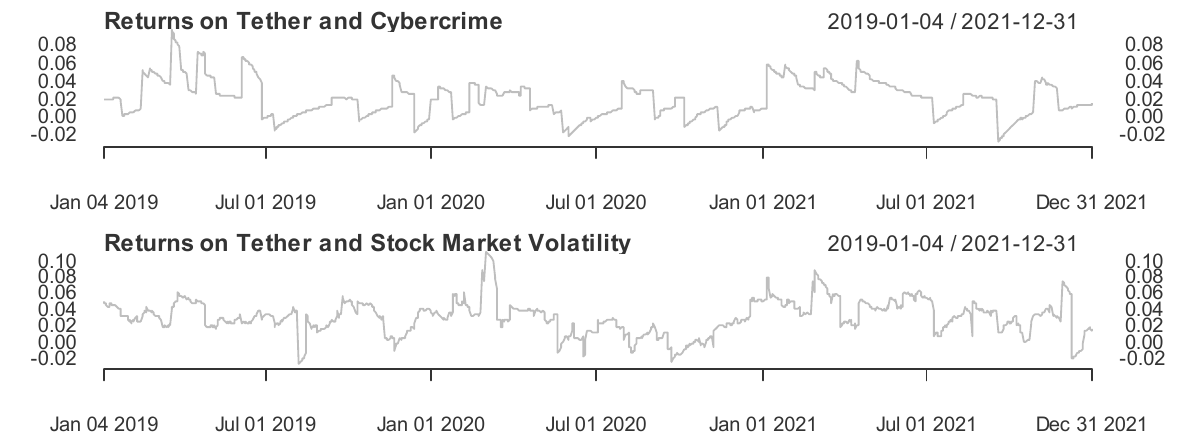
Figure 6. Time ‐ varying correlation coefficients between returns on Tether and cybercrime and stock market volatility.